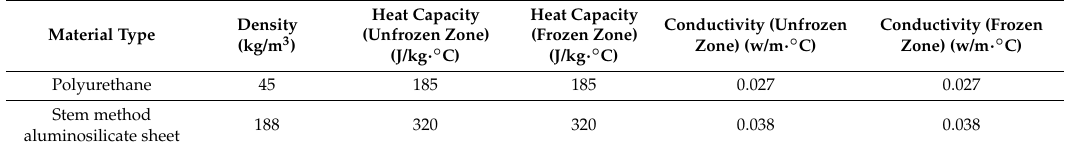
Table 2. Thermal physical parameters for different heat-insulating materials.